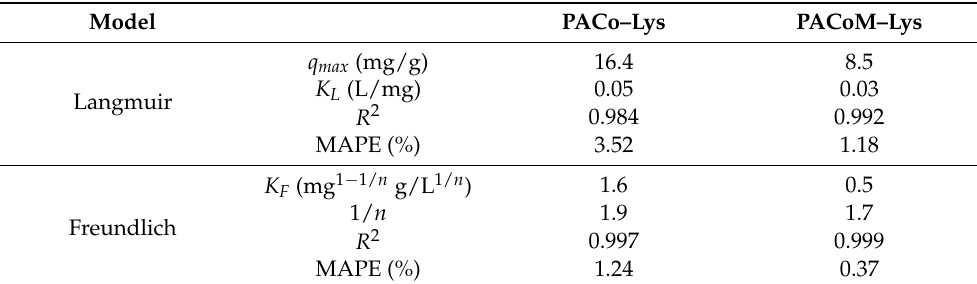
Table 5. Comparison of some adsorbents for ASA removal in terms of maximum adsorption capac- ity.